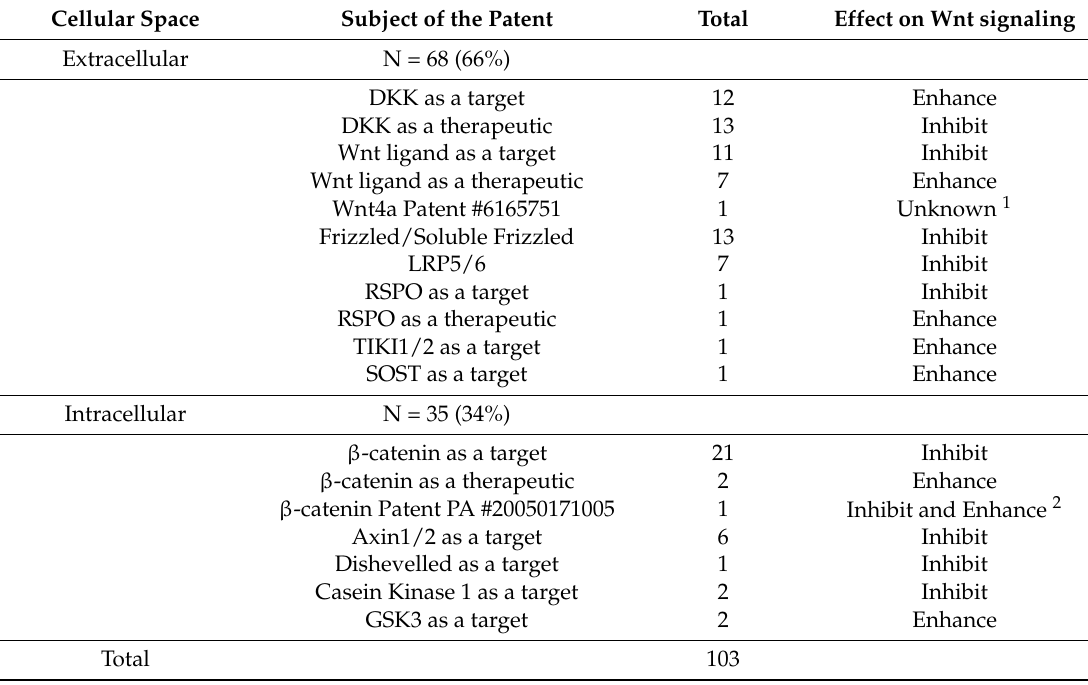
Table 2. Breakdown of unique patents and patent applications post